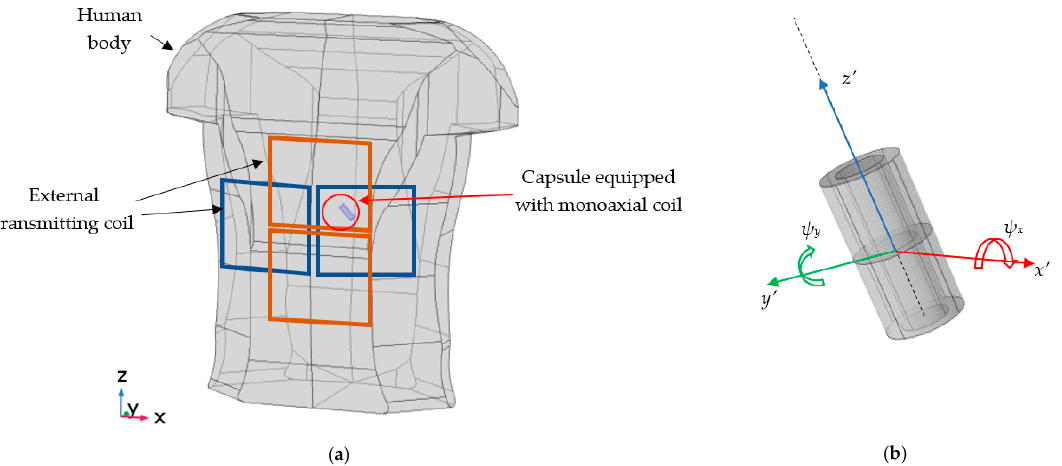
Figure 1. Proposed WPT setup. ( a ) Transmitter coil array consisting of 4 wearable rectangular coils. ( b ) Local coordinate system for a cylindrical capsule.